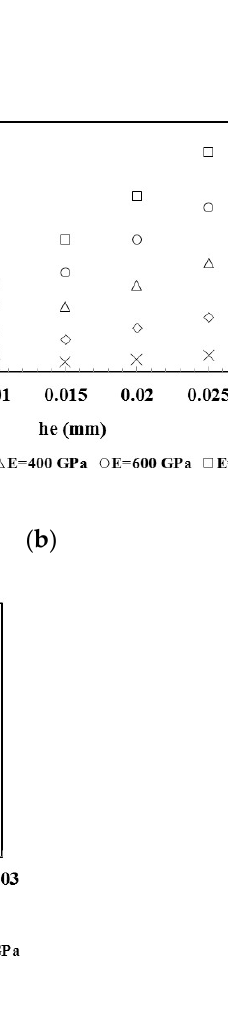
Figure 11. Evolution of load as a function of the elastic indentation depth obtained in the numerical simulations using flat indenters with different ratio R: ( a ) R = 1; ( b ) R = 4; ( c ) R = 7.11.